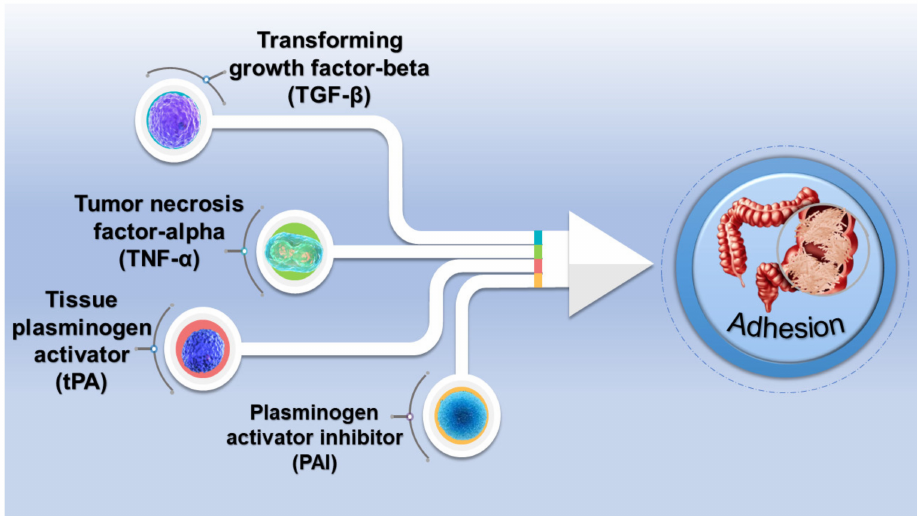
Figure 1. Some soluble mediators in adhesion